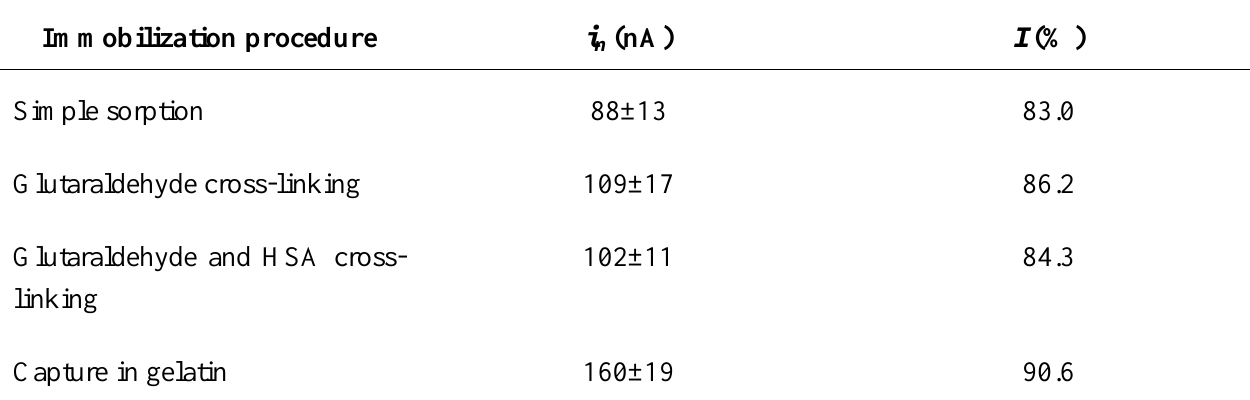
Table 1. Summary of AChE immobilization procedures, maximal current provided by non-inhibited biosensor i and percent of inhibition I are included. The dispersion n indicates standard